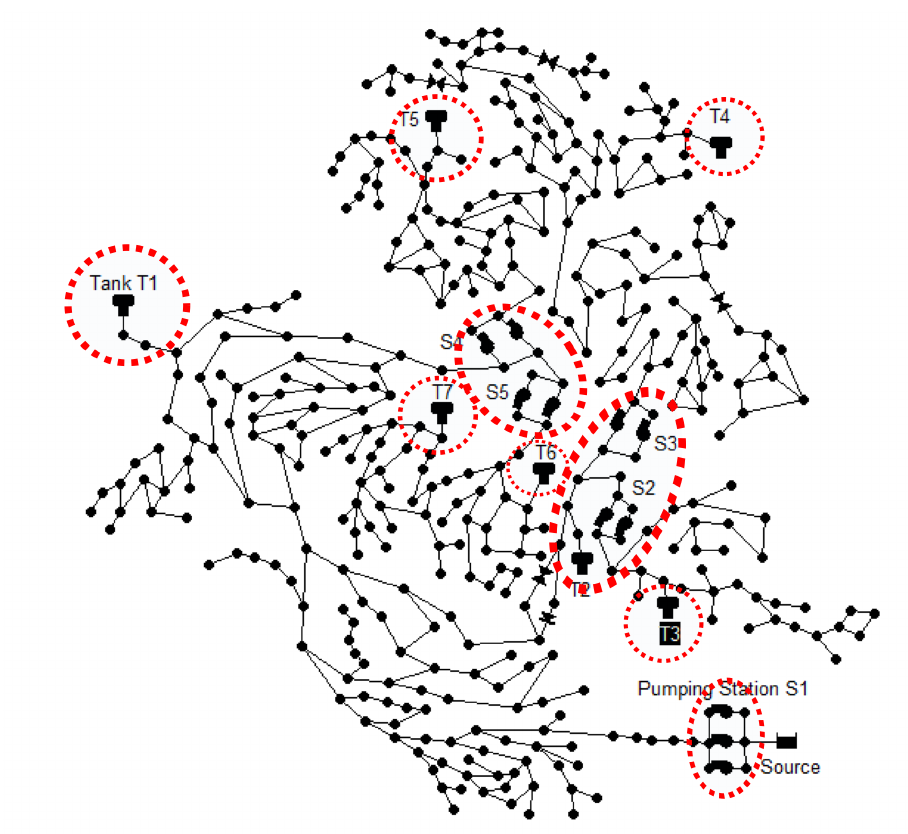
Figure 2. D-town water network topology highlighting potential attack